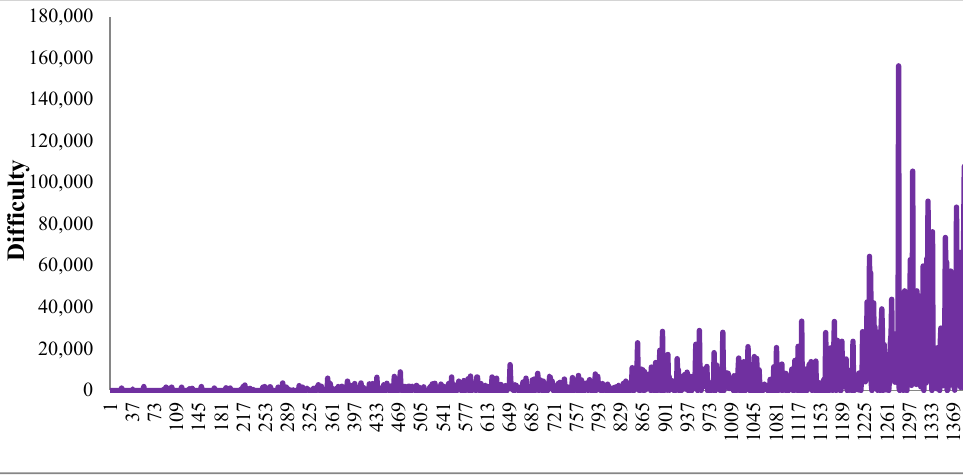
Figure 10. Difficulty of every slot allocation while weights set as [0,0,1] in test 3.